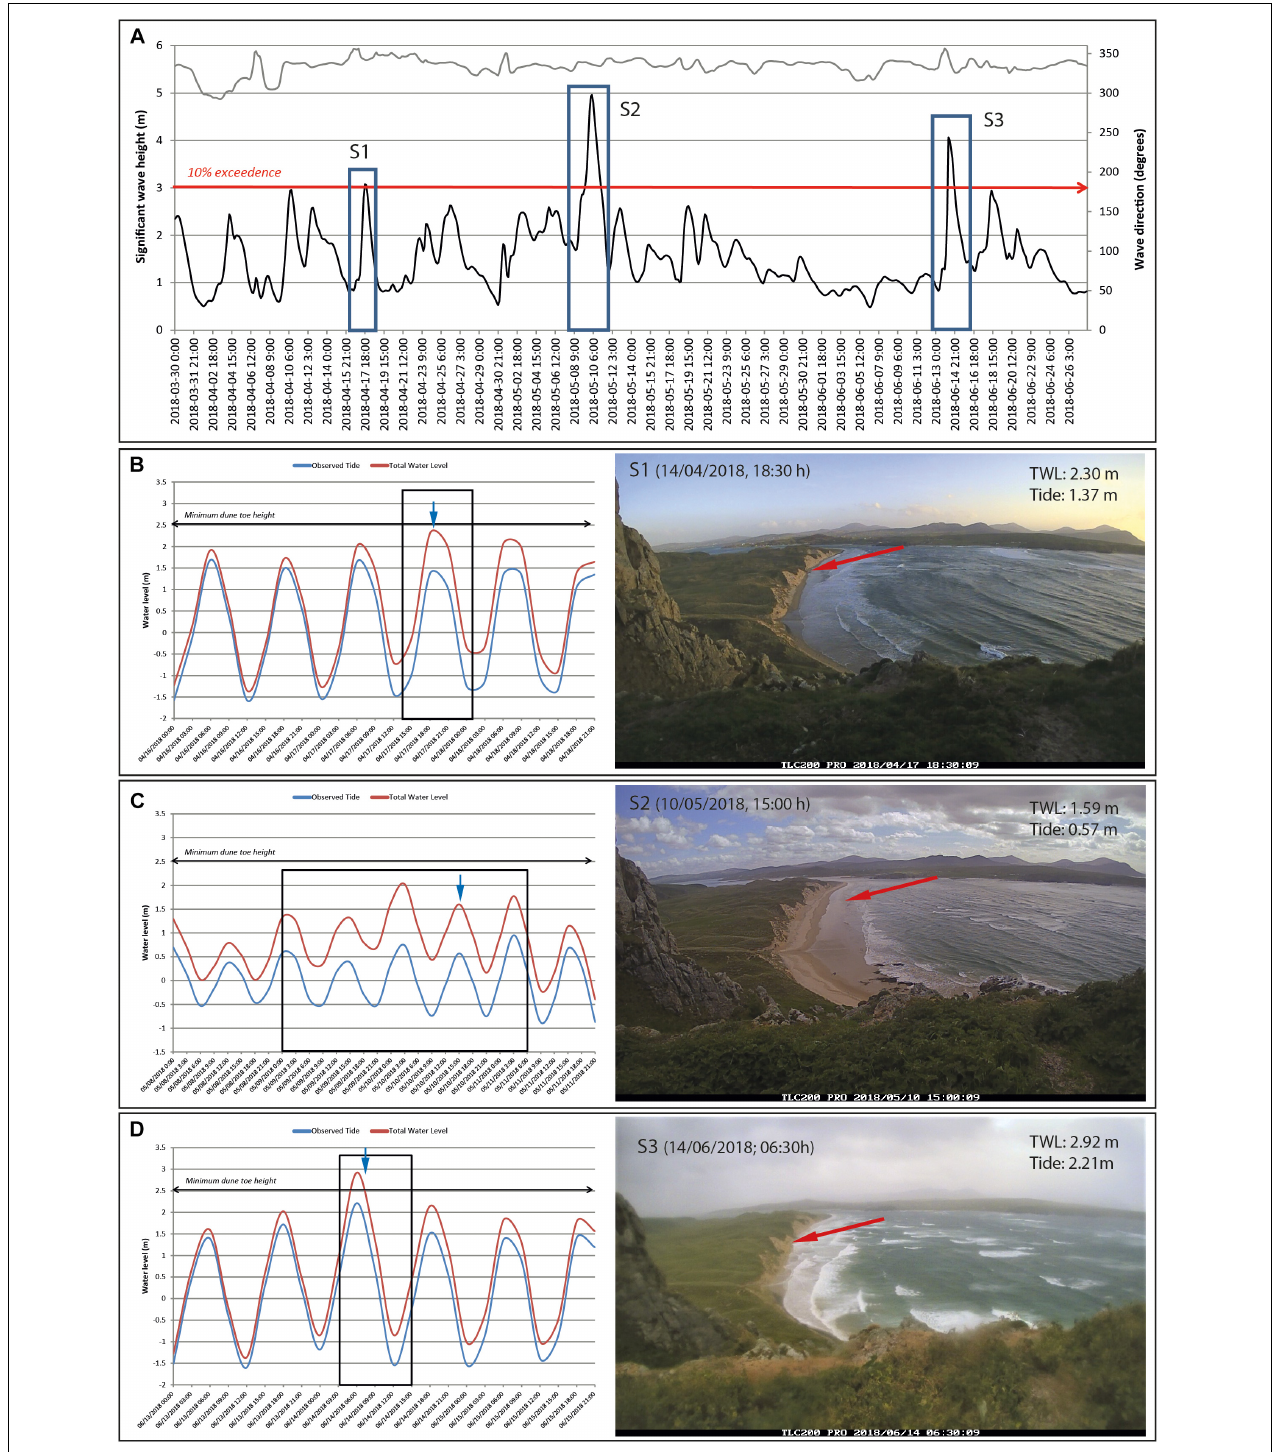
FIGURE 6 | Wave climate time series spanning Storm Hector (A) , where the left Y-axis accounts for H s (black line) and right Y-axis represents wave direction in degrees (top grey line). Note that in this panel black empty squares highlight storm events occurring between TLS/ topographic surveys (S3 corresponds to Storm Hector). (B–D) represent measured water levels and calculated Total Water Level (TWL) based on wave run-up for each storm event considered (left hand). On the right, time-lapse images representing either the storm’s wave height peak or the highest synchronisation of both wave height and water level during each storm analysed (S1–S3). Note that red arrows point to the maximum wave run up reached.